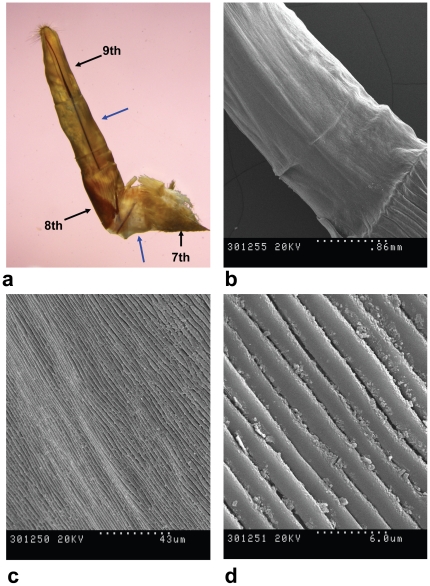

Paysandisia archon everted ovipositor and 8th/9th abdominal intersegmental membrane.
a, side view of fully everted ovipositor (×7.5); black arrows show from top to bottom the 9th, 8th and 7th abdominal segments; blue arrows show the intersegmental membranes between segments 9th-8th (top) and 8th-7th (bottom). b, 8th-9th intersegmental membrane showing what looks like a smooth surface (×35). c, idem, closeup at 700 magnifications showing multiple longitudinal smooth folds, allowing for extra ovipositor expansion. d, idem, closeup at 5000 magnifications.